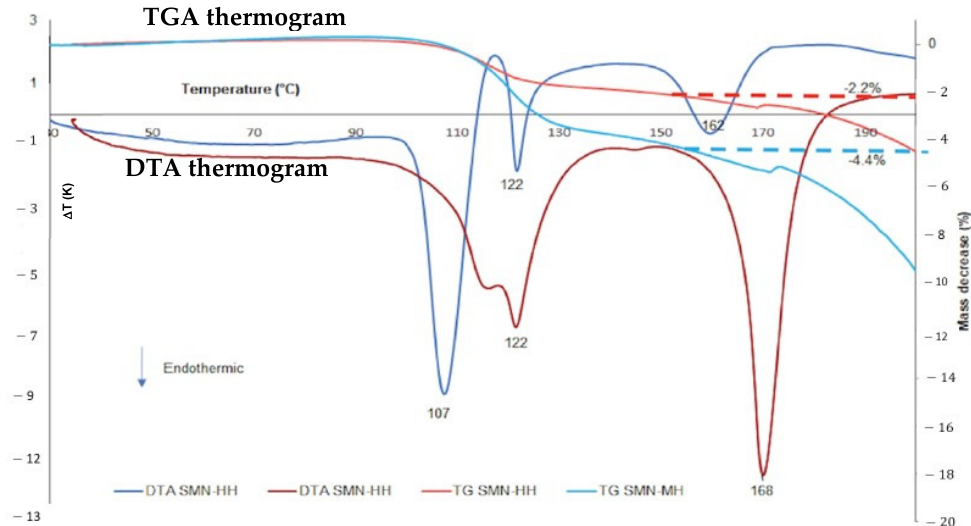
Figure 4. Thermogravimetry (TGA) and differential thermal analysis (DTA) of sodium mefenamic nicotinamide hemihydrate and monohydrate. Reprinted with permission from ref. [9]. Copyright 2021